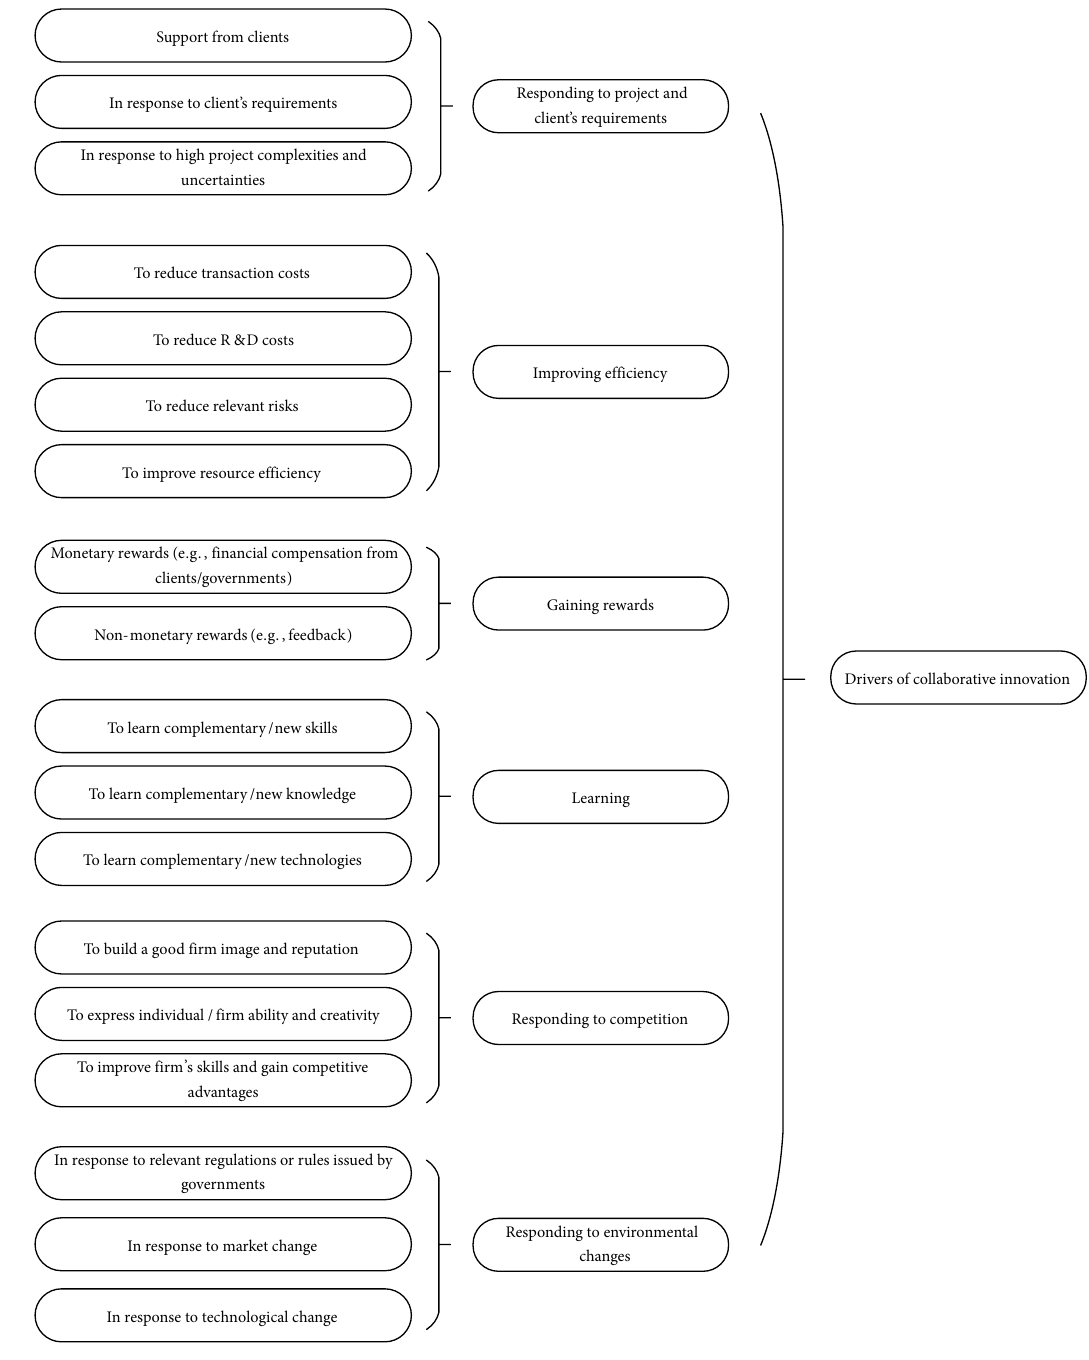
Figure 1. Division of 18 drivers into 6 main